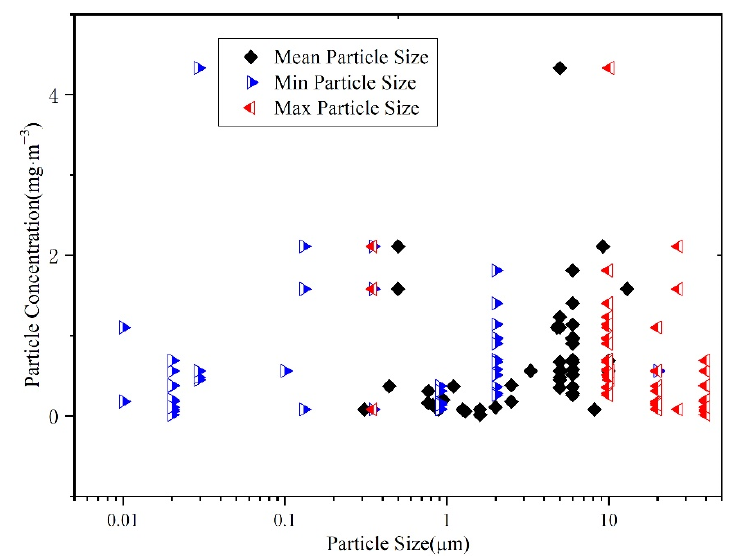
Figure 1. Oil particle concentration and size range in typical workshops.